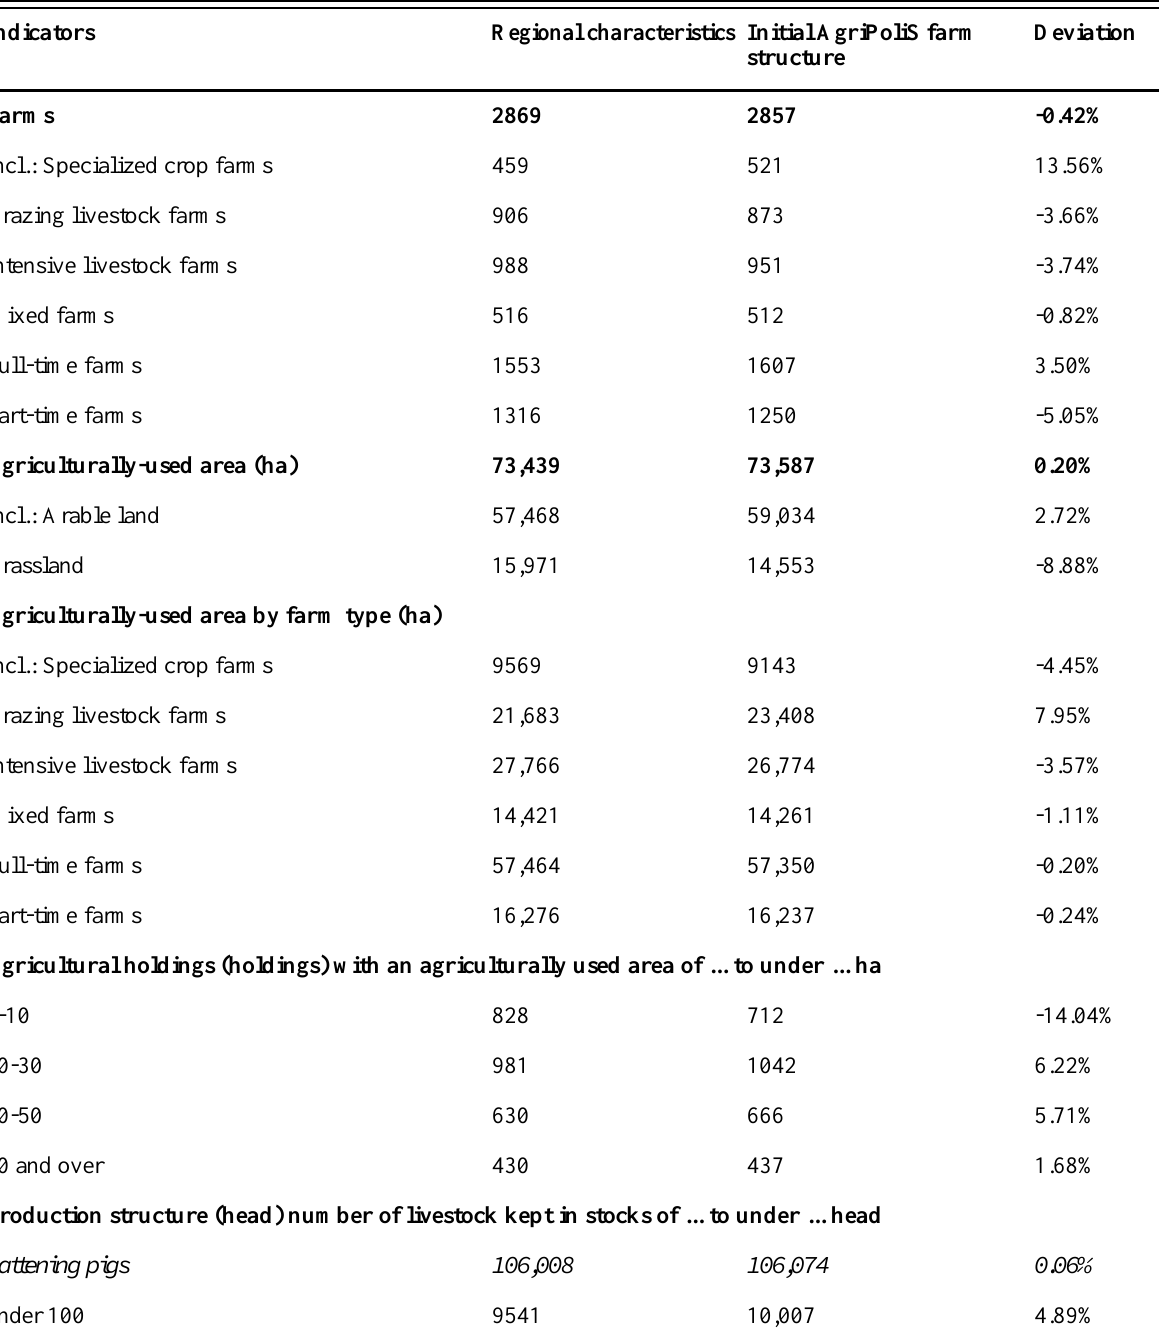
Table 4. Comparison of regional characteristics and initial virtual farm structure based on typical